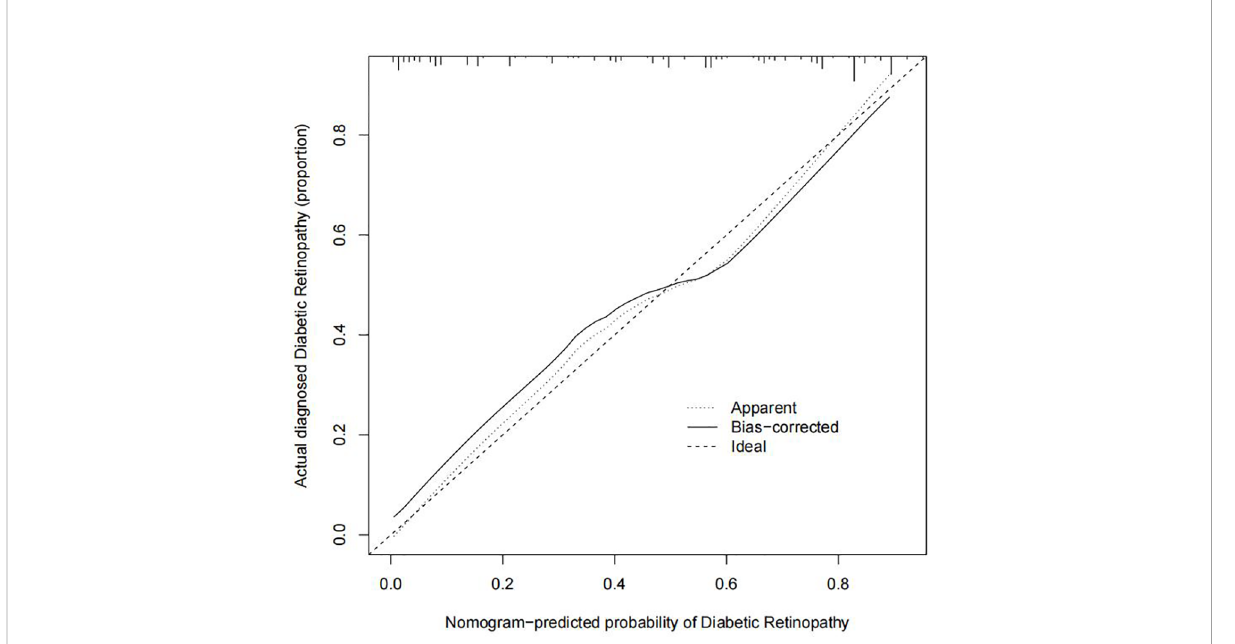
FIGURE 5 Prediction calibration curves of the diabetic retinopathy (DR) nomogram. The x-axis represents the possibility for DR. The x-axis re fl ects the nomogram-predicted probability. The y-axis re fl ects the actual predicted probability. A perfect prediction model describes an ideal forecast. The graph depicts the fi tness of the nomogram for forecasting outcomes, the dotted line indicating a more reliable